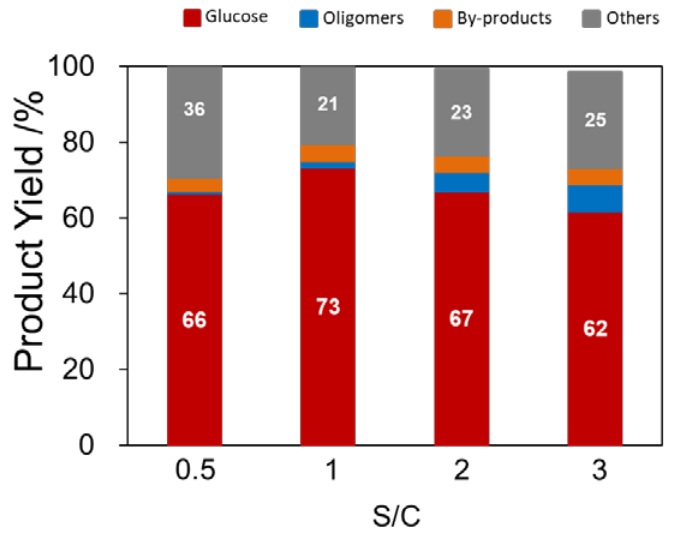
Figure 8. Yield of products after hydrolysis of cellulose pretreated with H 3 PO 3 with different substrate-to-catalyst ratios. Wet cellulose + AC-Air mixture, 40 mL water, 180 °C, 20 min. By-products include fructose, 5-HMF and levoglucosan. “Others” is the difference between cellulose conversion and identifiable products.